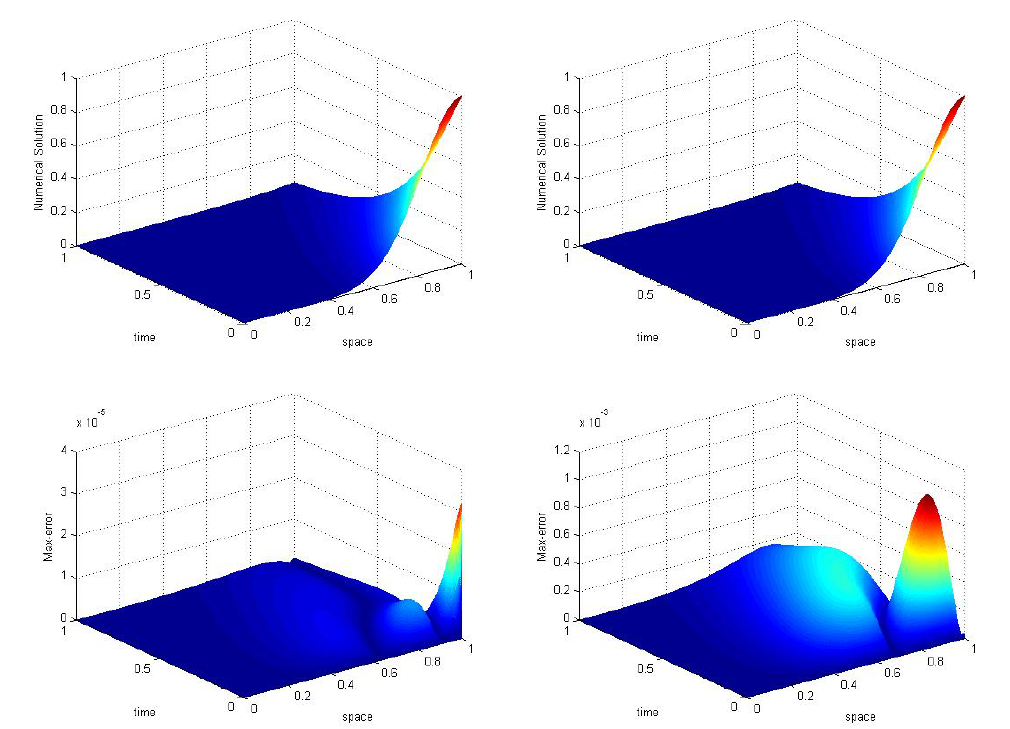
Figure 5. Numerical solution and max-error of modified FVM ( left ) and existing upwind FVM ( right ) for convection dominant phenomenon taking ( ∆ t = 1/15000, ∆ x = 1/320 v = 1, k = 0.07 for numerical example 2.)